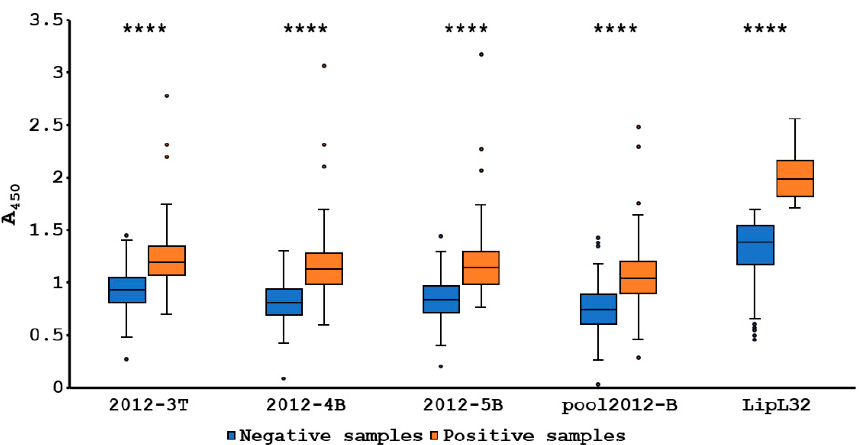
AUC = area under ROC curve; Sn = sensitivity; Sp = specificity; PPV = positive predictive value; NPV = negative predictive value; Ac = accuracy; K = kappa value. Figure 4. Box plot of absorbance at 450 nm of positive and negative samples of each peptide and LipL32 based on ELISA results. The significant differences between positive and negative results were analyzed using a Mann–Whitney U test (**** represents p < 0.0001).